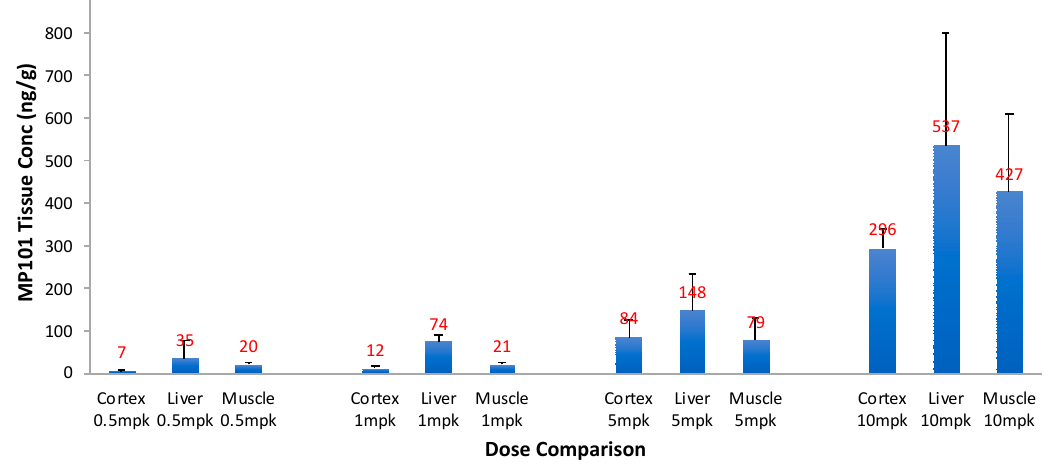
Figure 5. MP101 (DNP) tissue concentrations (ng/g) in mice. Six-month aged male C57/bl6 mice were